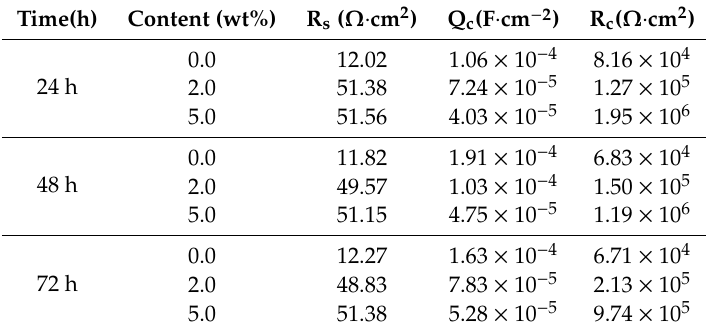
Figure 7. Equivalent circuit models used to fit the experiment impedance data of scratched coating immersion in seawater. ( a ) Equivalent circuit model in the early stage of immersion ( b ) Equivalent circuit model in the middle and late stage of immersion. Table 1. EIS parameters of the scratched coating immersing in